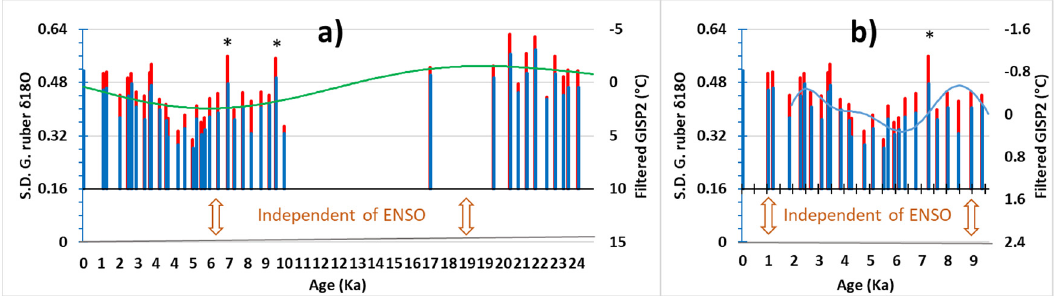
Figure 8. Variations in the δ 18 O standard deviation of individual G. ruber from the Holocene and Last Glacial Maximum. The high bar in red of snapshots represents the square root of the total variance of δ 18 O obtained from all the data while the low bar in blue excludes the heaviest and lightest value from each distribution. The bar on left indicates the 1958–2007 monthly δ 18 O standard deviation from instrumental SST and salinity. Values marked with an asterisk are recognized as doubtful by the author [35]—( a ) Obtained from Greenland Ice Sheet Project 2 (GISP2) δ 18 O record filtered in the 18.4—36.9 Ka band, a proxy of long-term adjustment of geostrophic forces is drawn in green (the record is converted into the global temperature T through the calibration T = 1.42 × δ 18 O + 49.0)—( b ) GISP2 δ 18 O record is filtered in the 2.3–4.6 Ka band.